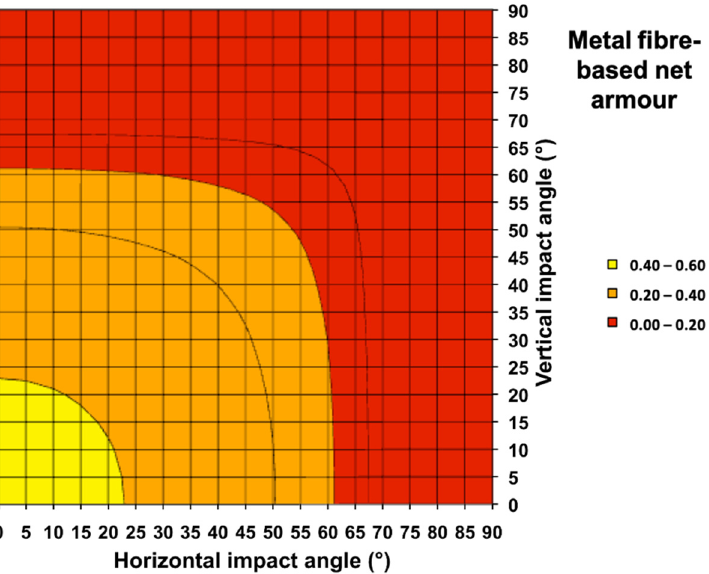
Figure 21. Efficiency of a metal fibre-based net cage armour solution as a function of the horizontal and vertical impact angle.